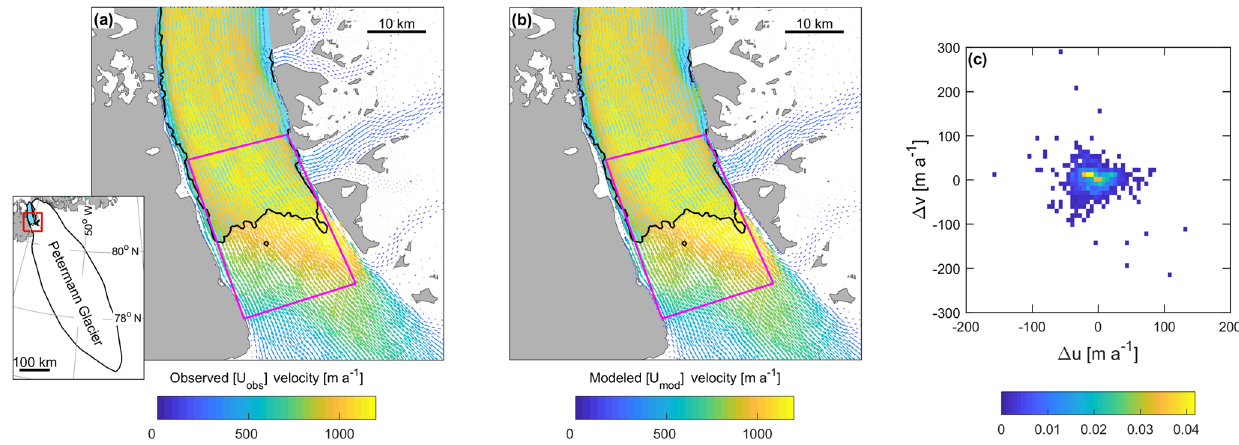
Figure 3. Observed ( U obs ) winter velocities 2009/10 (a) in the proximity of the grounding line. (b) Modeled ( U mod ) velocities. Panel (c) shows a normalized bivariate histogram of the velocity residuals, which are the difference between modeled and observed velocities in the vicinity of the grounding line (magenta). (cid:49)u = u mod − u obs and (cid:49)v = v mod − v obs . u and v are x and y components of the velocity vectors, respectively. Table 2. Misfit between observed and modeled velocity for each boundary condition scenario. Mean Mean Mean Mean percentage velocity velocity velocity Boundary condition scenario difference difference difference difference (%) (ma − 1 ) ( > 300ma − 1 ) ice tongue (ma − 1